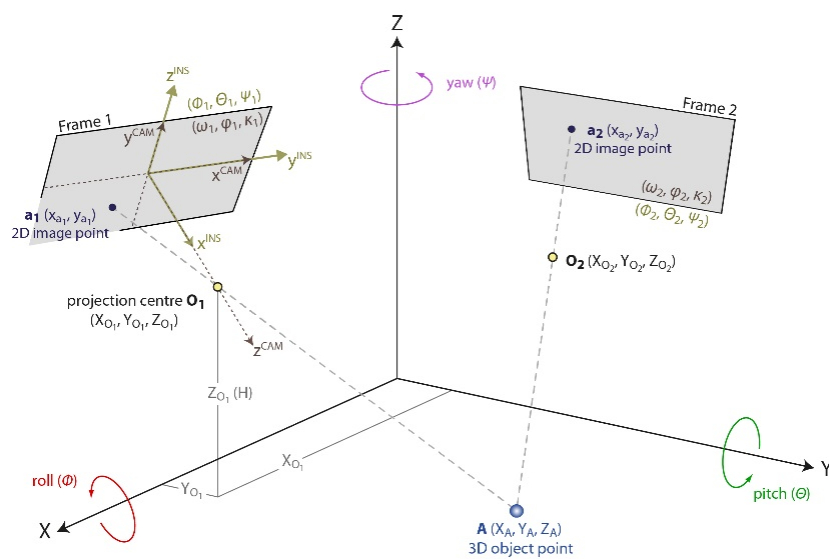
Figure 2. The exterior orientation of a photograph in relation to a global coordinate reference system (CRS) (X, Y, Z) (illustration by G. Verhoeven).